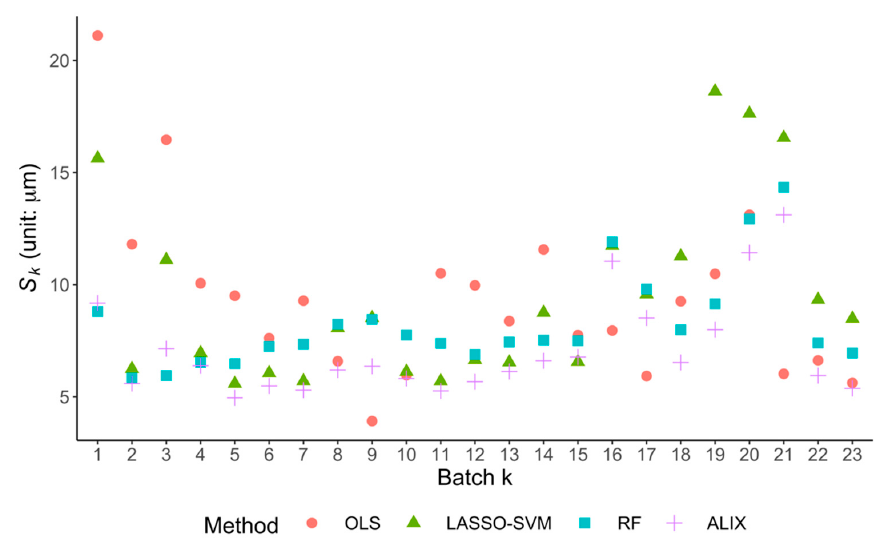
Figure 8. Results of S k for each model that is trained on batch k .